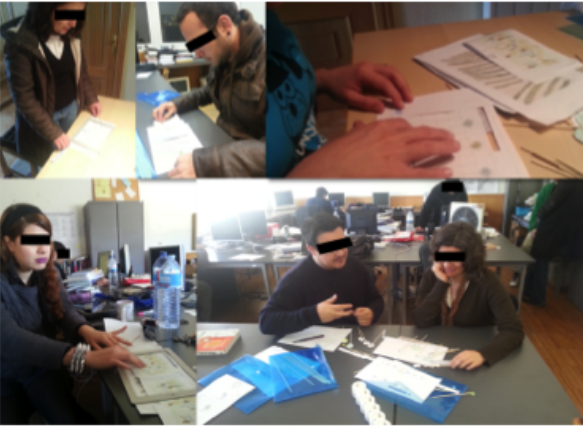
Fig. 6. Design Walkthrough with the experts